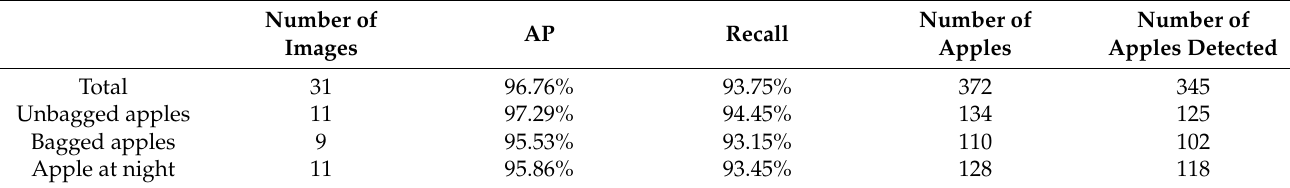
Table 3. Detection results in different